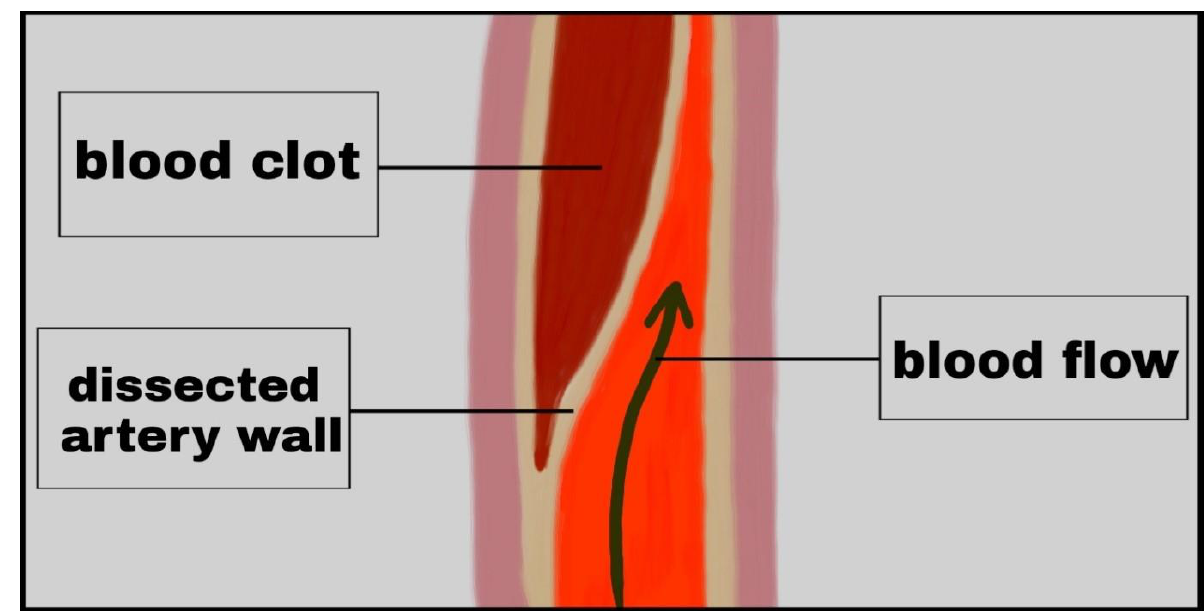
Figure 4. Arterial dissection.